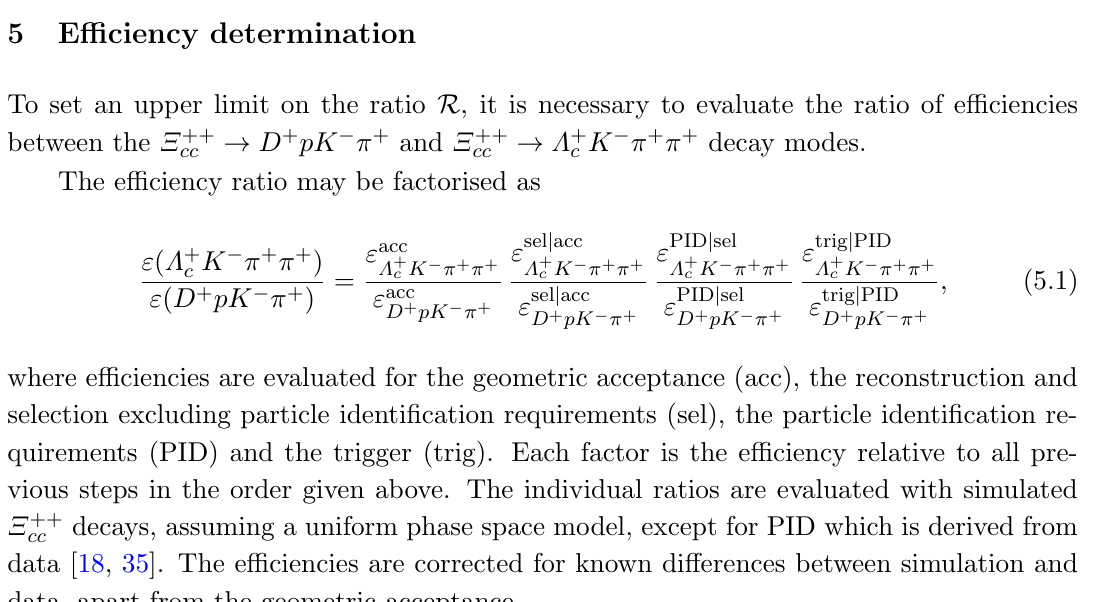
Figure 4 . Invariant-mass distribution of the (cid:4) ++ The black points represent data, the dashed (green) line represents combinatorial background, the dotted (red) line represents the signal contribution and the continuous (blue) line is the total